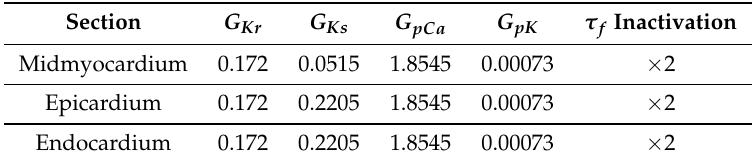
Table A1. Parameter values used during VF simulations for the TP06 model. Parameters not included in this table take the same values reported in [30]. Modified parameters are the maximum conductance of the I Kr , I Ks , I pCa and I pK currents. The time constant of the f gate was also modified.